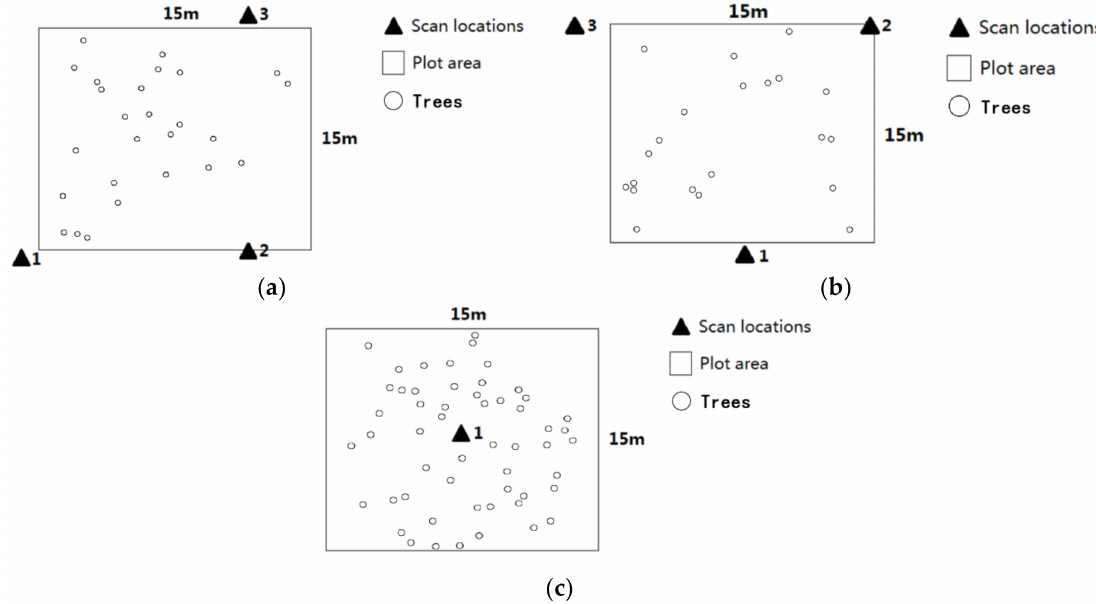
Figure 3. Scan locations within the plots. ( a ) plot 1; ( b ) plot 2; ( c ) plot